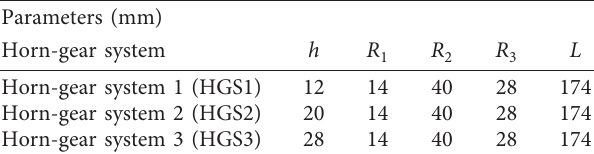
Figure 3: (a) The three gears and (b) the one horn. Table 2: Dimension parameters of the three horn-gear